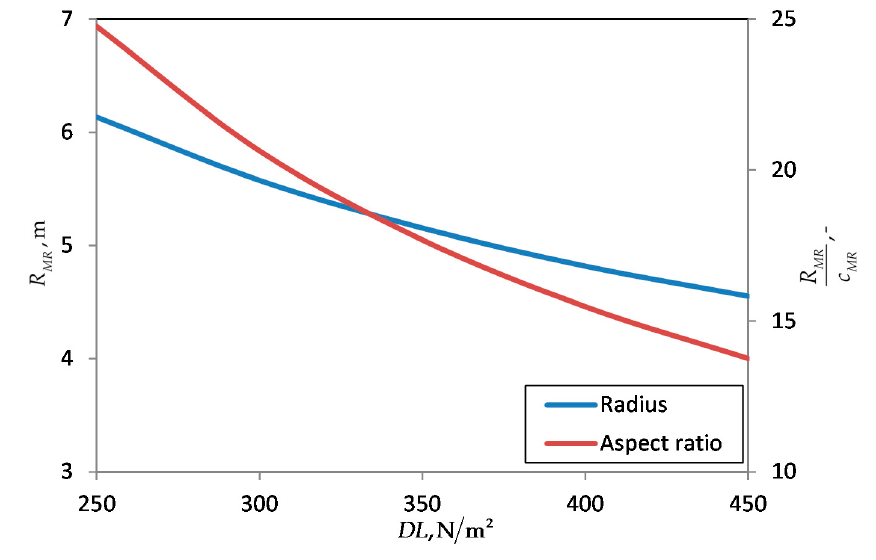
Figure 16. Rotor radius and aspect ratio over disc loading with constant blade loading R MR ,- MR